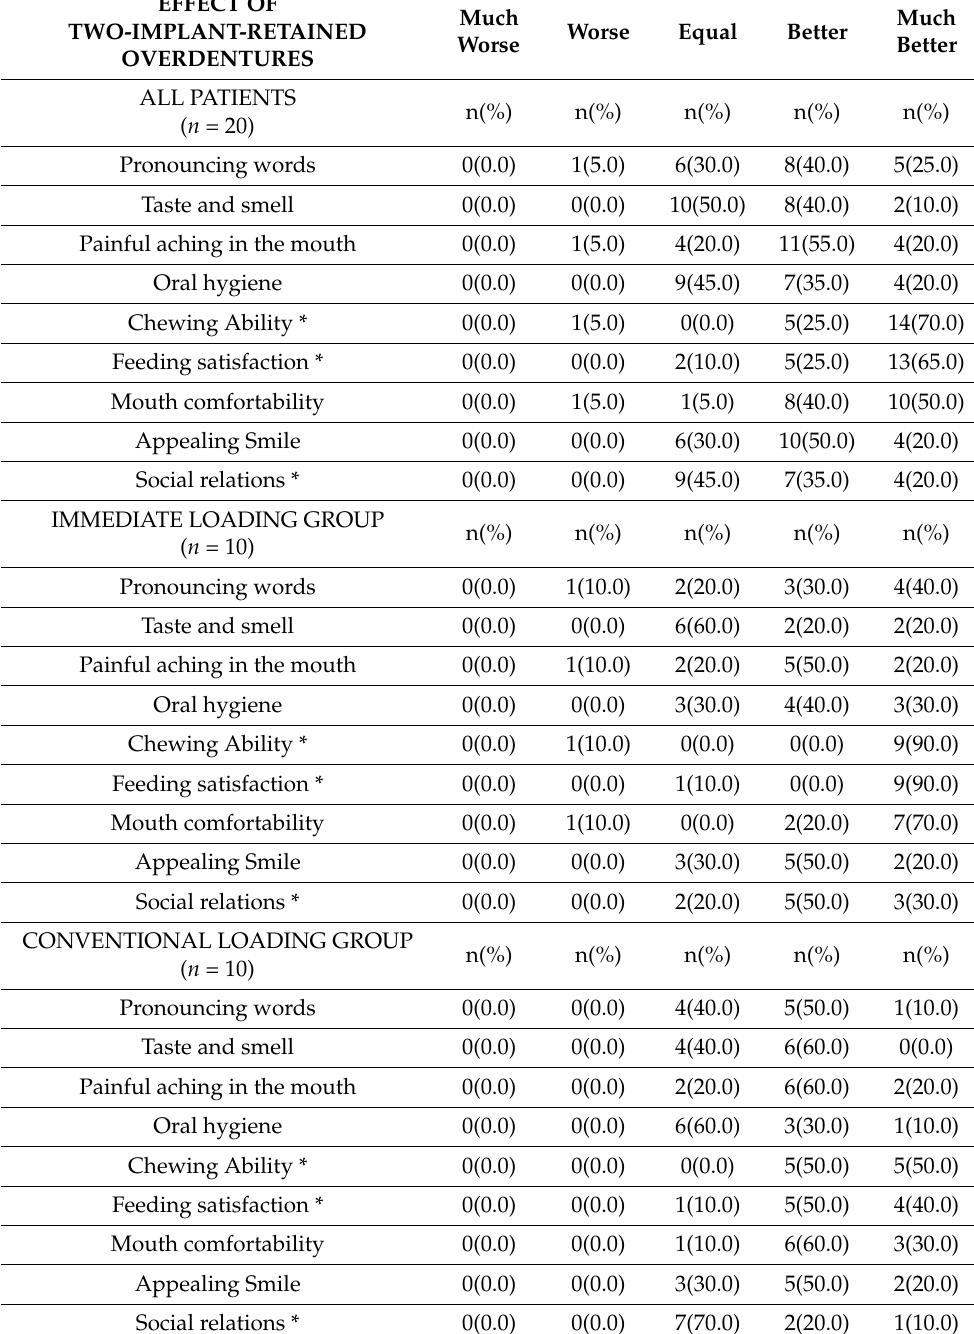
Table 11. Retrospective evaluation of the prosthetic treatment (implant-retained overdentures) by global transition items in the whole sample ( n = 20) and within loading